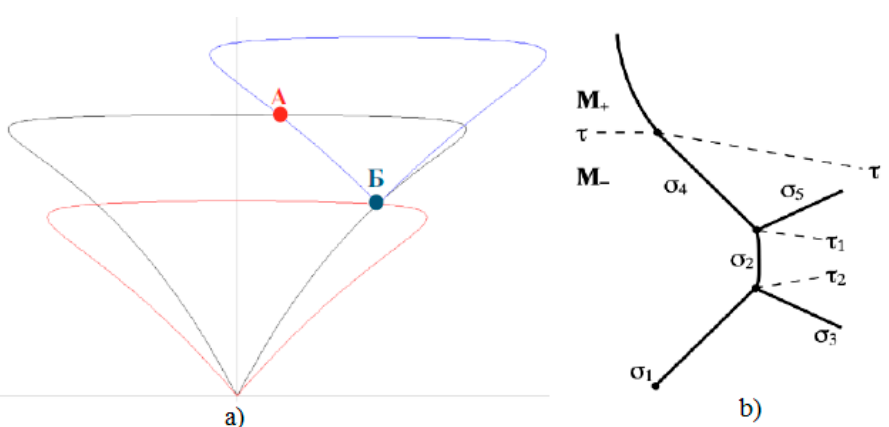
Figure 14. Ambiguity of the solution on the polar plane: irregular refraction (A), characteristic refraction (B): ( a ) solutions on the plane of shock polar, ( b ) shock wave structure corresponding to the Mach refraction MRef.